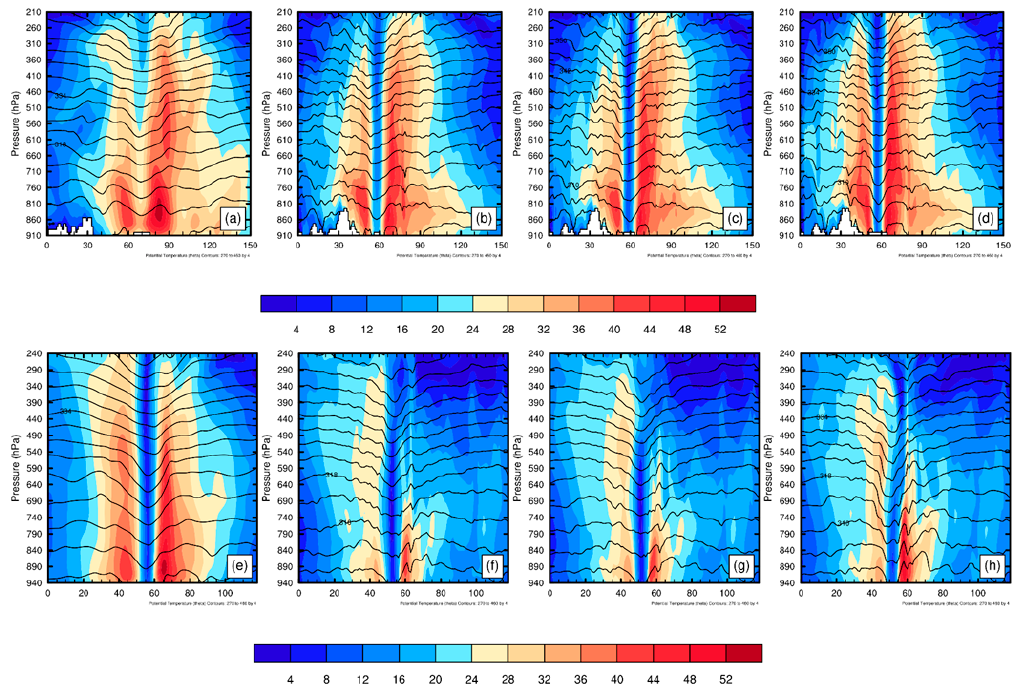
Figure 12. The west–east cross-sections of analyzed horizontal wind speed (shaded) and potential temperature (contours; intervals of 4K) for Chan-hom ( a – d ) and Nangka ( e – h ) from ECMWF ( a , e ), CON ( b , f ), CLEARSKY ( c , g ) and ALLSKY ( d , h ) experiments. The x-axis is grid number.